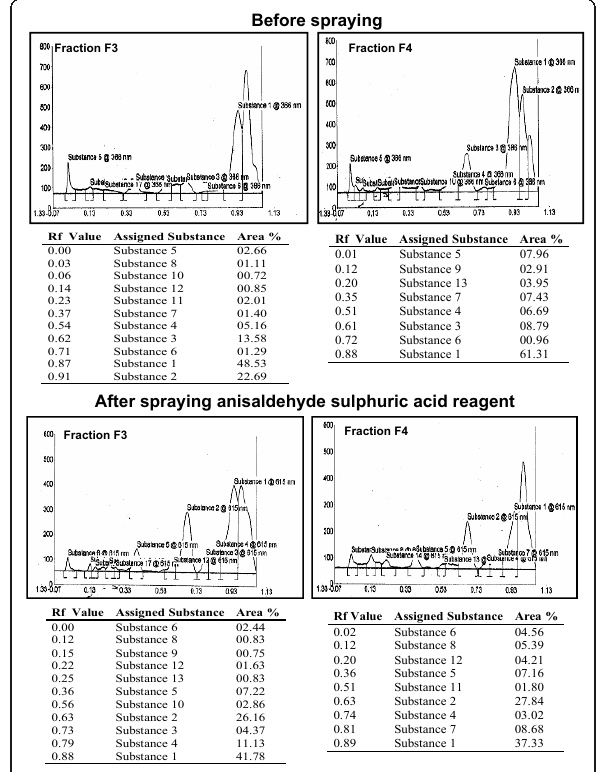
Figure 6 HPTLC profiling of B. pinnata leaf extract, fraction F3 and F4 (A) Finger printing of B. pinnata leaf extract, fraction F3 and F4 before and after spraying anisaldehyde sulphuric acid reagent at UV (366 nm) and visible (615 nm) light . Tables represent Rf value of the detectable substances in fractions with their relative content. Constituent substances were designated with numbers accordingly to their decreasing order of relative abundance.